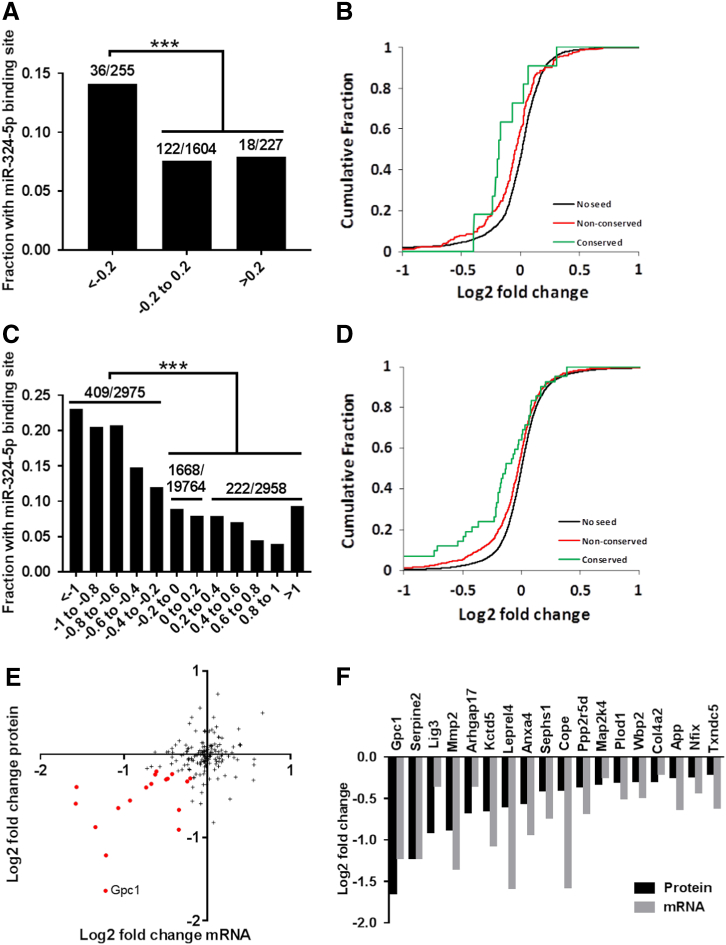
miR-324-5p target identification in Ihh treated mouse C3H10T1/2. (A) Enrichment of genes containing 3′UTR miR-324-5p binding sites within genes whose protein decreased (<log2 −0.2) following miR-324-5p transfection. (B) Cumulative fraction plot showing enrichment of conserved and non-conserved miR-324-5p binding site containing genes whose protein expression decreased following miR-324-5p over expression. (C) Enrichment of genes containing 3′UTR miR-324-5p binding sites within genes whose RNA decreased (<log2 −0.2) following miR-324-5p transfection. (D) Cumulative fraction plot showing enrichment of conserved and non-conserved miR-324-5p binding site containing genes whose transcript expression decreased following miR-324-5p over expression. (E) Proteomic and transcriptomic expression for 176 genes identified at a protein and mRNA level and also contain a miR-324-5p seed binding site, 18 of which decreased at an mRNA and protein level (highlighted in red). (F) Bar chart showing log2 fold change in protein and RNA expression for the 18 potential targets following miR-324-5p transfection. Enrichment significance for miR-324-5p binding site containing genes was calculated using Chi-squared test, where ***p < 0.001.